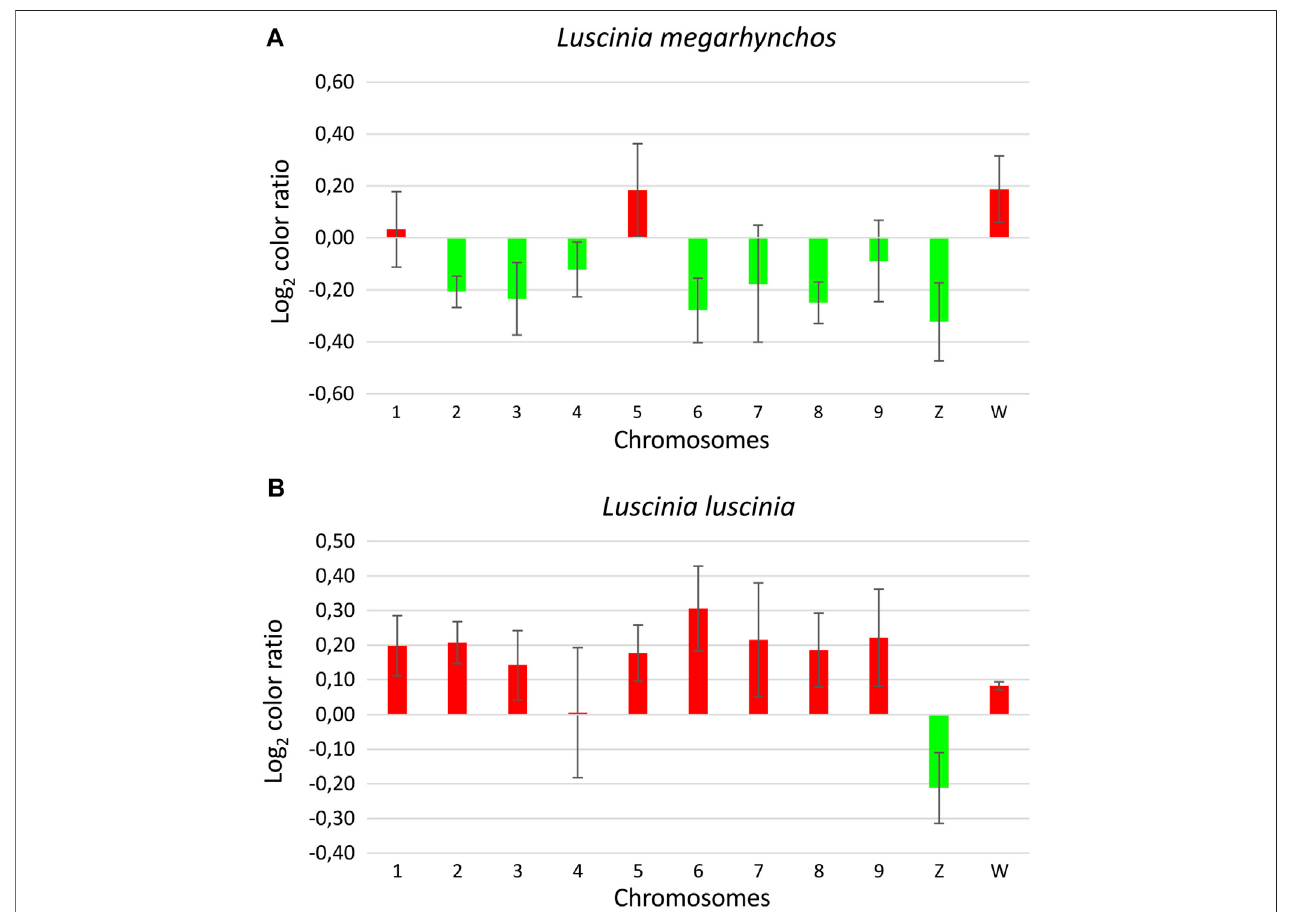
FIGURE 6 | Ratio of the green and red signal intensity at centromeric regions from the interspeci fi c comparative genomic hybridization (CGH) experiment with the common nightingale ( L. megarhynchos ) metaphases (A) and the thrush nightingale ( L. luscinia ) metaphases (B) . Log 2 color ratio is shown for nine macrochromosomes and the sex chromosomes. Values lower than zero represent higher signal of common nightingale probes (green) and values higher than zero represent higher signal of thrush nightingale probes (red). Bar charts are based on the Log 2 ratio with error bars representing the standard error.